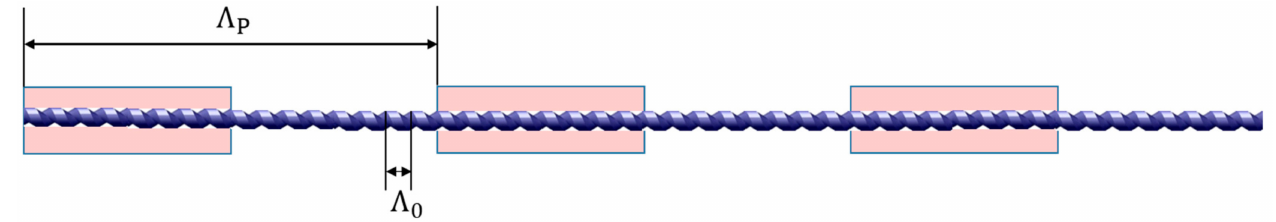
Figure 35. Schematic structure for the proposed DC-sampled HLPG. Adapted with permission from ref. [177]. © [2022]